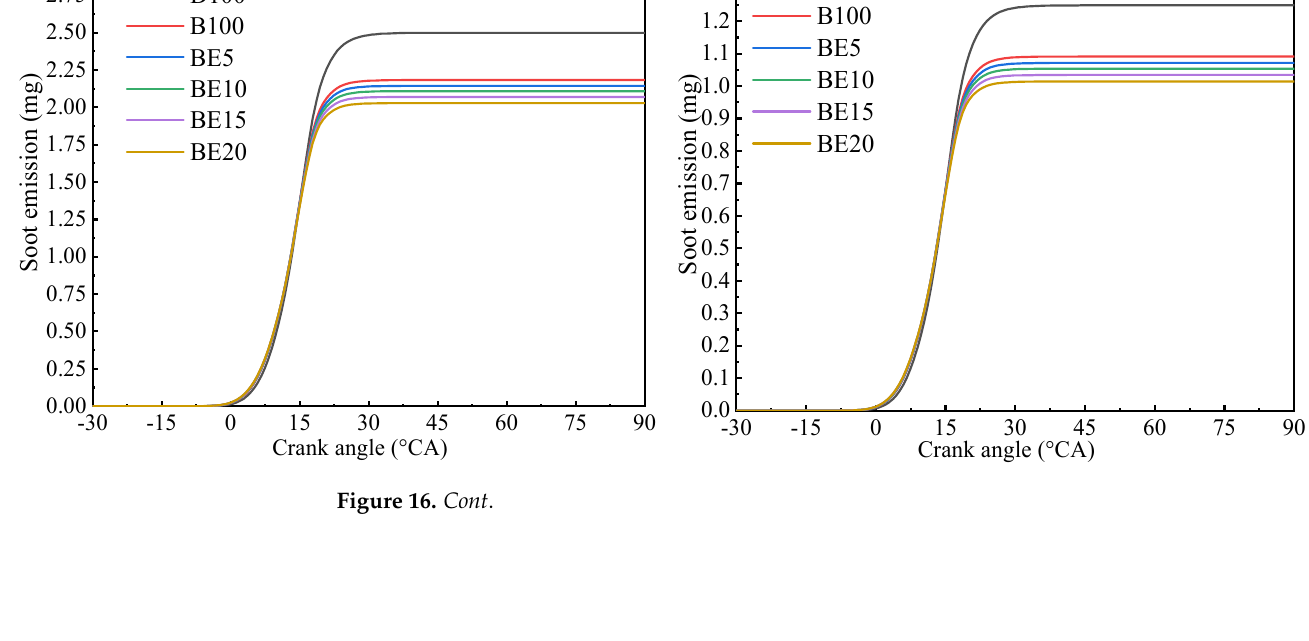
Figure 16. Comparison of soot emission for different blended fuels at different loads. ( a ) 100% Load, ( b ) 75% Load, ( c ) 50% Load, ( d ) 25% Load. 4. Conclusions With the increasing shortage of energy and the continuous deterioration of the envi ‐ ronment, it is urgent to find renewable, carbon ‐ neutral green energy [52–54]. In this paper, a CFD model was established and validated by experiment results. An improved CHEM ‐ KIN code including 122 species and 430 reactions was employed to simulate the combus ‐ tion process. Then, the validated model was used to investigate the effect of different